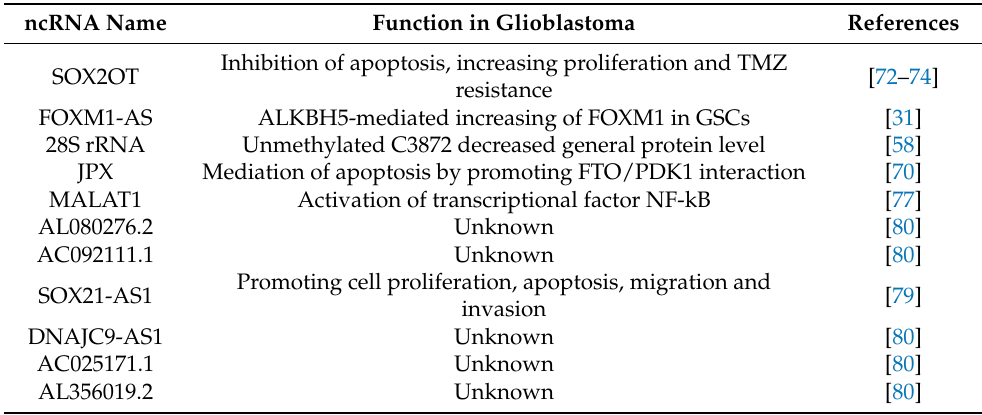
Table 1. Non-coding RNAs mentioned in the